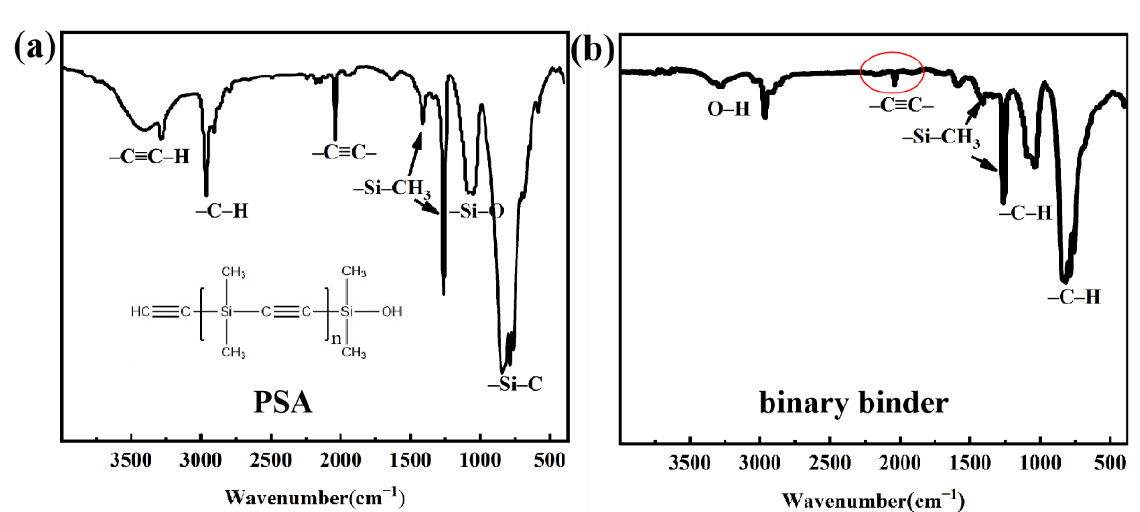
Figure 2. FT-IR spectra of ( a ) PSA and ( b ) binary binder (red circle is attributed to –C≡C– bond) .